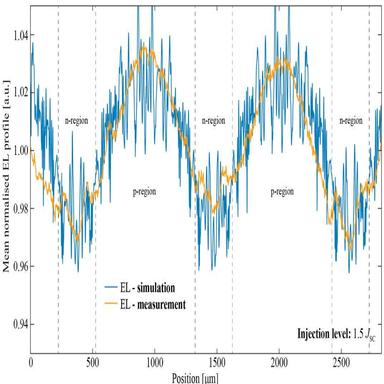
Comparison between the measured and the simulated EL profiles of the Zebra IBC at 1.5 JSC injection level taking into account all optical and electrical effects discussed in previous subsections.